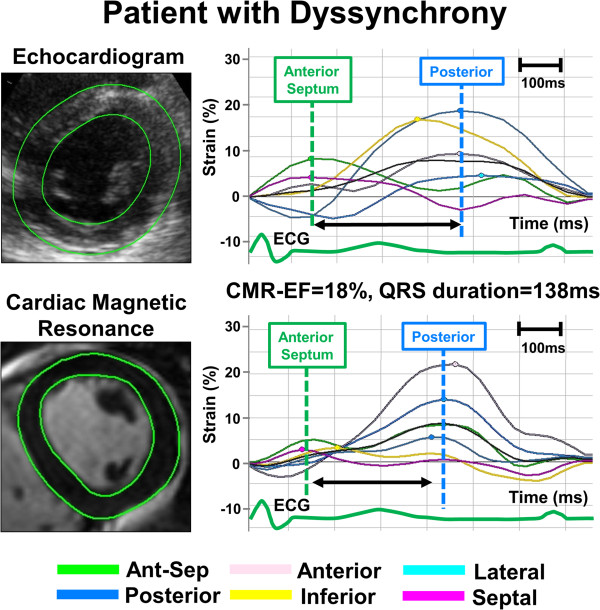
Example of radial time-strain curves by speckle tracking echocardiography (top panel) and feature tracking CMR (bottom panel) in a patient with left ventricular (LV) dyssynchrony, demonstrating dyssynchronous time-to-peak-strain curves with early peak strain in anterior septum (Ant-Sep) segment (green curve) and delayed peak strain in posterior lateral segments (deep blue curve).